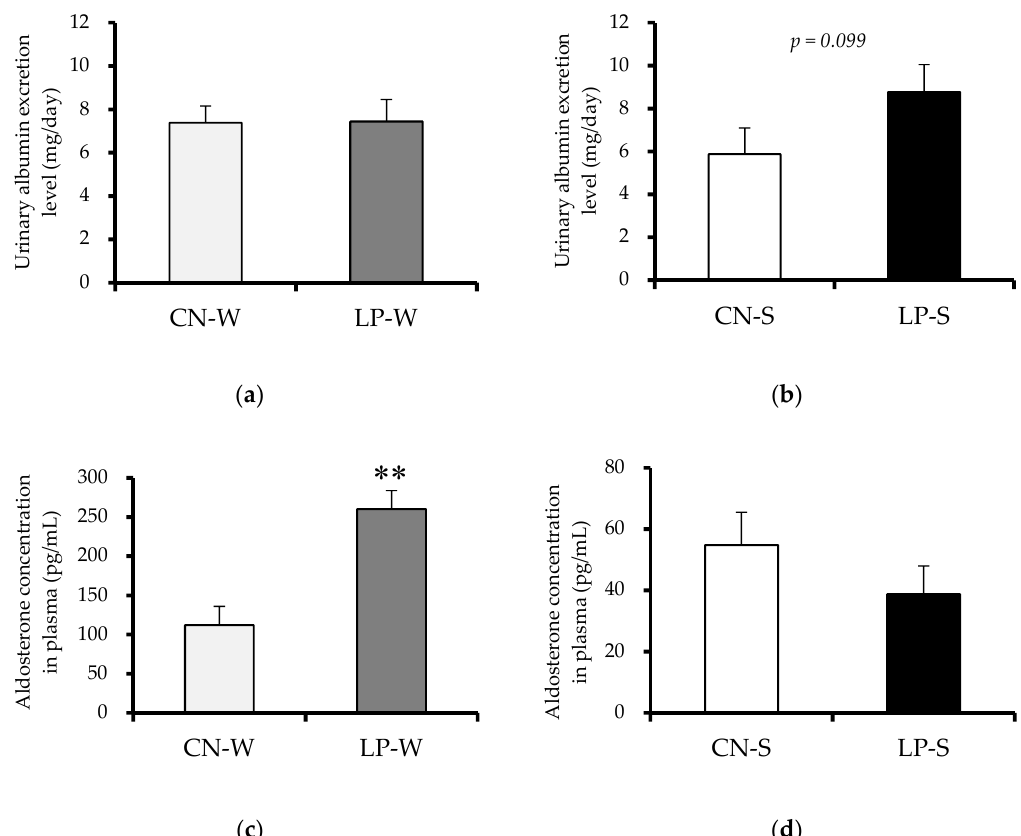
Figure 2. Effect of low protein intake during pregnancy on the exhibition of renal damage markers by offspring at 12 weeks after birth. ( a ) Offspring urinary albumin excretion levels (Animal Experiment 1). ( b ) Offspring urinary albumin excretion levels (Animal Experiment 2). ( c ) Aldosterone concentration levels in offspring plasma (Animal Experiment 1). ( d ) Aldosterone concentration levels in offspring plasma (Animal Experiment 2). Values are expressed as the mean ± standard error ( n = 7–8). ** p < 0.01 vs. the CN-W group according to a Student’s t -test. Offspring were exposed to either an intrauterine environment of 20% (CN)-feeding mothers or that of 9% (LP)-Casein diet-feeding mothers, and provided with either water (W) or 1% saline drinking supply (S).